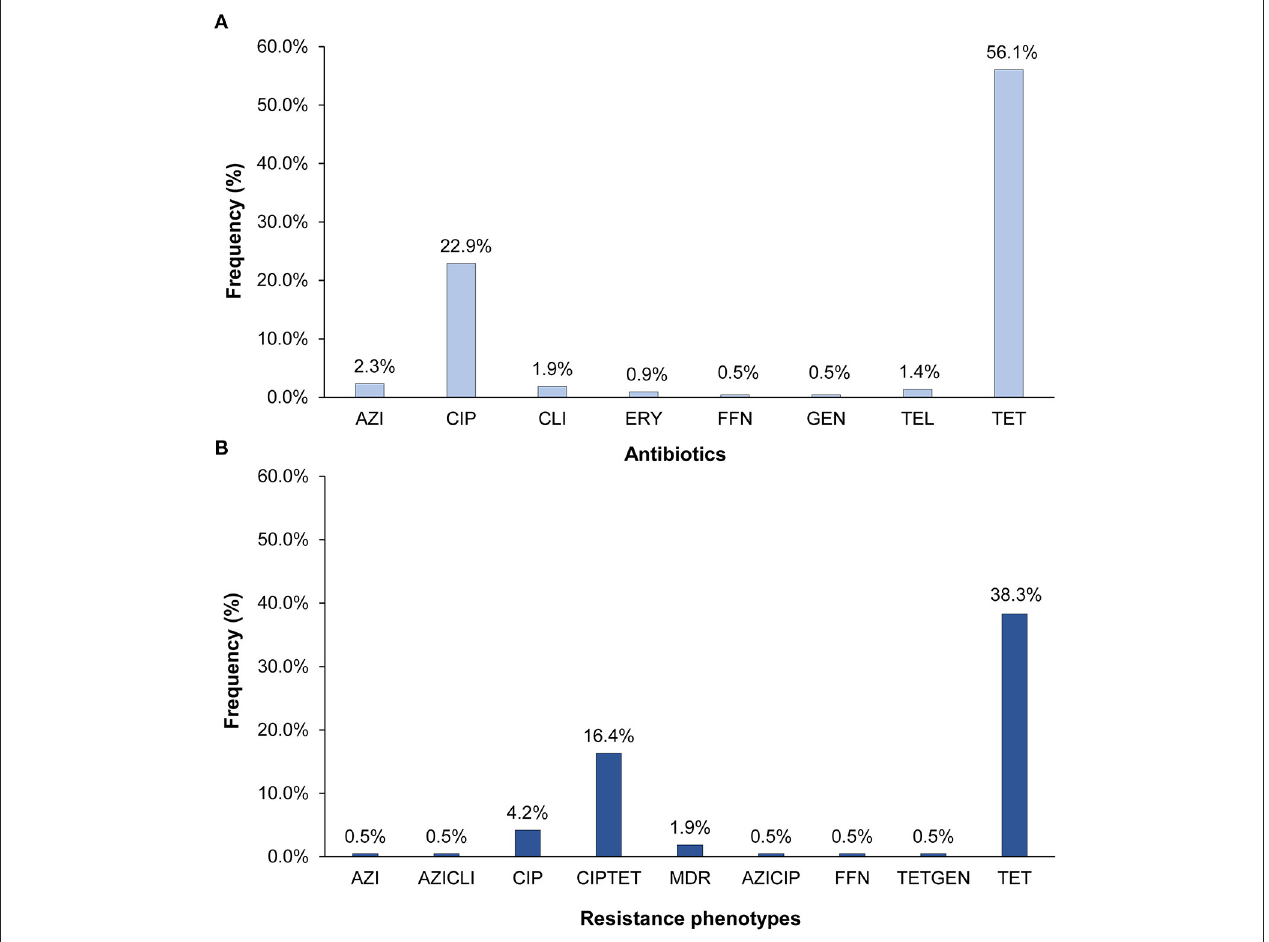
FIGURE 1 | Percentage of the 214 Campylobacter jejuni isolates with (A) resistance to eight different antibiotics and (B) distinct antibiotic resistance phenotypes. AZI, azithromycin; CIP, ciprofloxacin; CLI, clarithromycin; ERY, erythromycin; FFN, phenicol; GEN, gentamicin; TEL, telithromycin; TET, tetracycline. The multidrug resistant (MDR) phenotype includes isolates with resistance to CIPAZIERYCLITEL, CIPTETCLI, and CIPTETTEL. All CIP resistant isolates were also resistant to nalidixic acid.